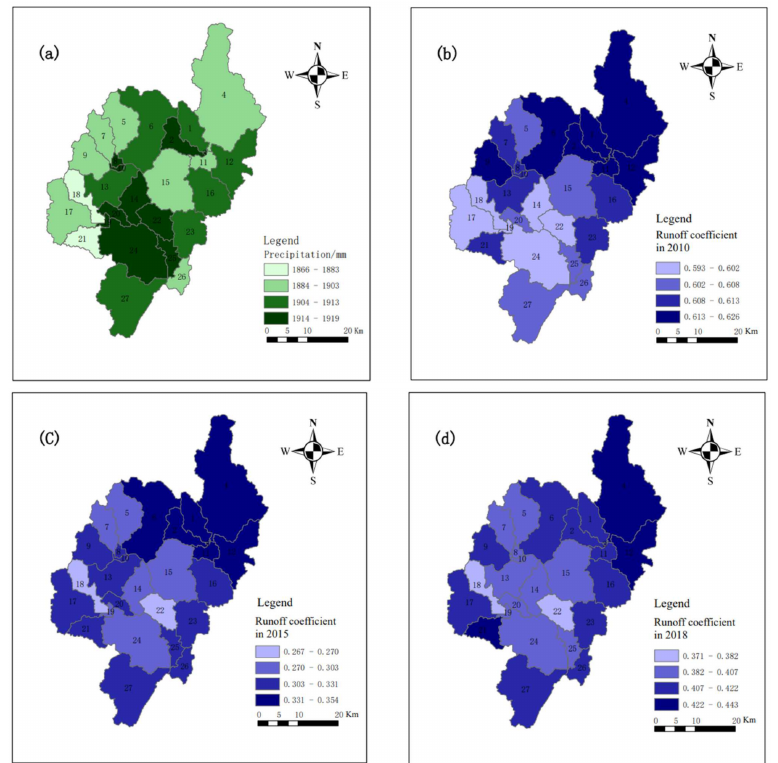
Figure 7. Annual precipitation distribution ( a ), and runoff coefficient distribution map in 2010 ( b ), 2015 ( c ), 2018 ( d